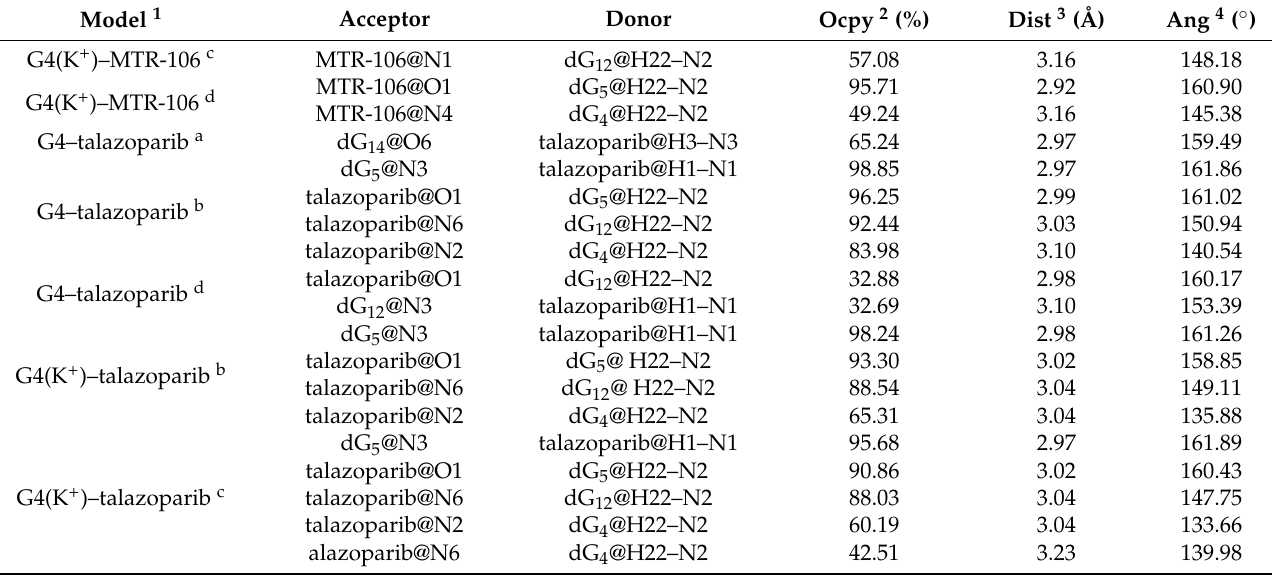
Table 2. Intermolecular hydrogen bonds between PARP1 G4 and the binding